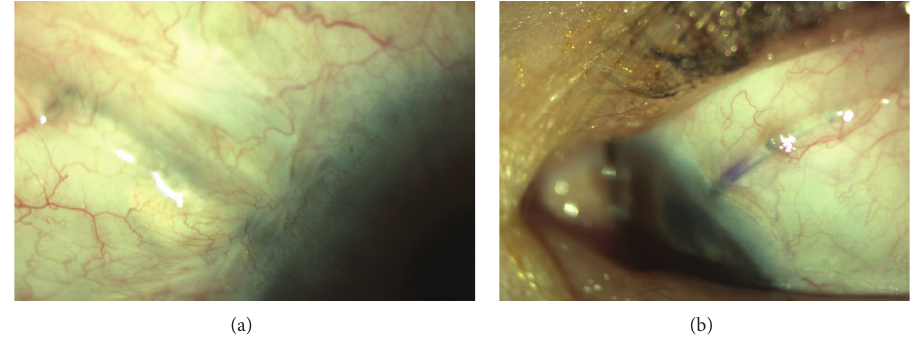
Figure 1: (a) Intact conjunctiva over graft. Note that the graft is not clearly visible. (b) Eroded tube in eye implanted with keraSys patch